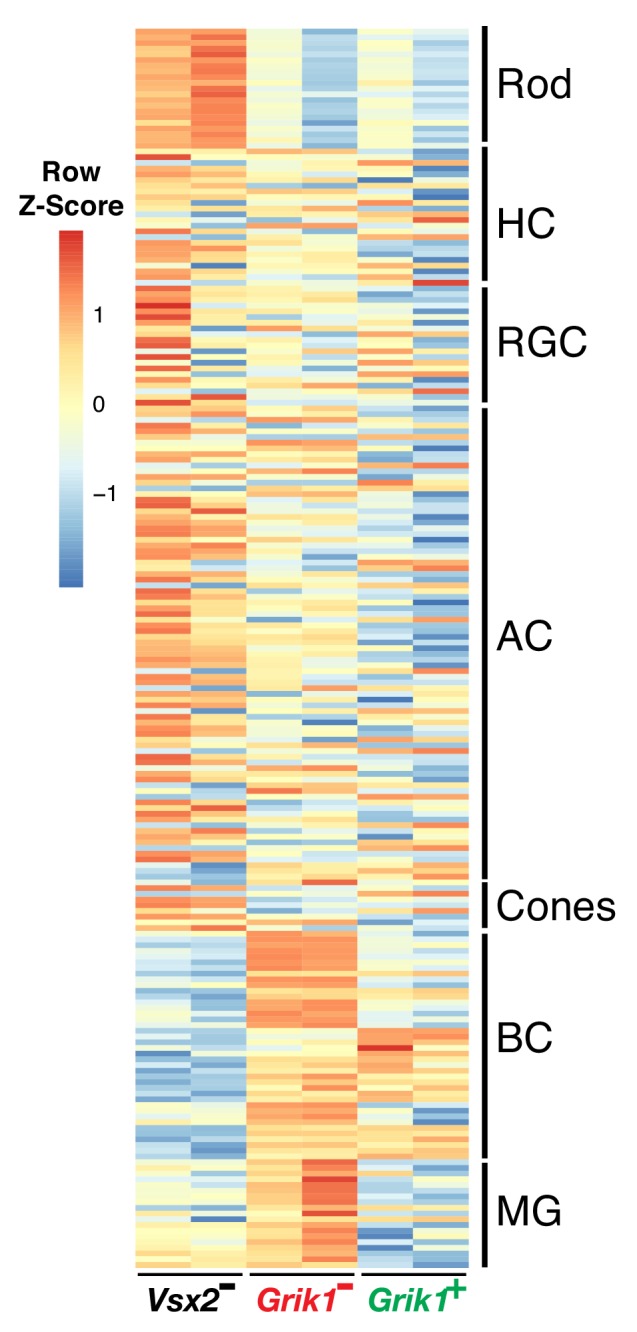
BC markers are enriched in the Vsx2+/Grik1+ and Vsx2+/Grik1- populations.A heatmap representing relative expression levels of major retinal cell class markers previously identified by scRNA sequencing (Macosko et al., 2015) that are differentially expressed (adjusted p-value<0.05) between Vsx2-, Grik1-, and Grik1+ populations.